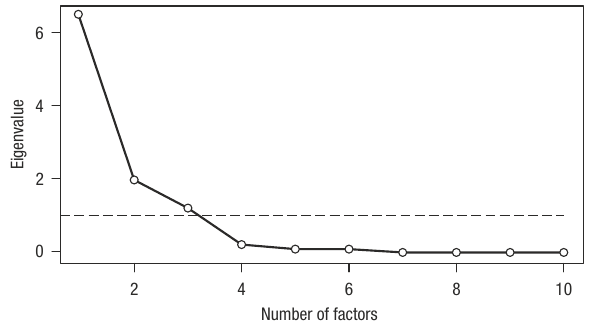
Figure 3. Eigenvalues of the factors obtained in the factor